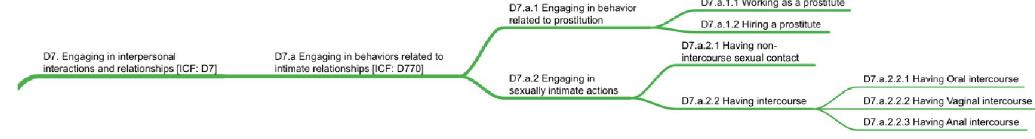
Fig 9. D7 domain on engaging in interpersonal interactions and